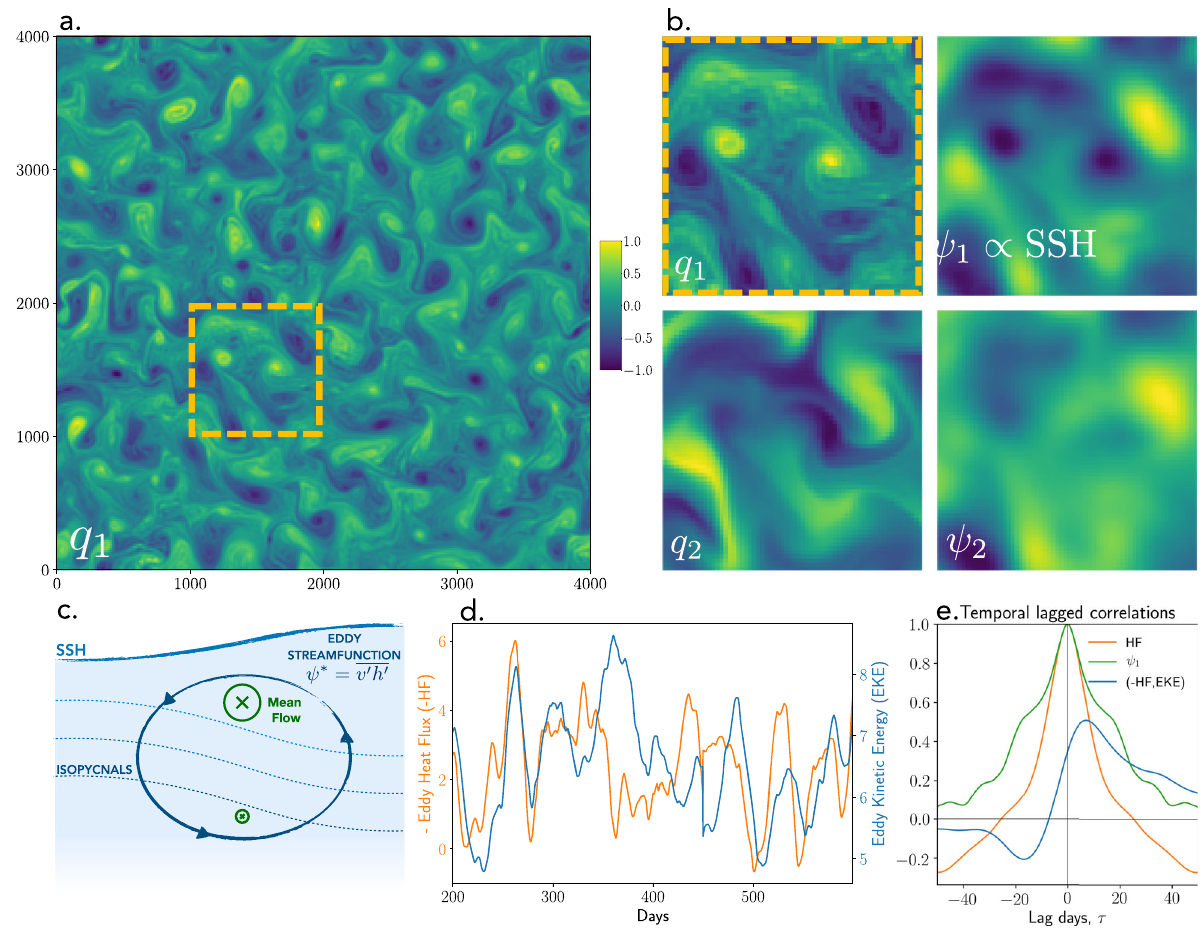
Fig. 1 Simulations of baroclinic geostrophic turbulence on a β -plane. a Snapshot of the upper-layer potential vorticity fi eld, q 1 , showing the prominence of mesoscale eddies; orange dashed square shows a representative 1000 × 1000 km subdomain. b Subdomain snapshots of potential vorticities q i and streamfunctions ψ i in the upper ( i = 1) and lower ( i = 2) model layers. Note, the sea surface height ( SSH ) is proportional to the top layer streamfunction, ψ 1 . All variables have been non-dimensionalised such that their extremal pixel has a value of modulus 1. c Cross-sectional schematic of a strati fi ed ocean, demonstrating the thermocline tilt and corresponding vertically sheared mean fl ow (for the northern hemisphere); the cumulative impact of all eddies creates an overturning eddy streamfunction, ψ *, that acts in a direction to fl atten the thermocline slopes and decelerate the mean fl ow. d Temporal evolution of the subdomain-averaged eddy heat fl ux HF (it ’ s negative is plotted with the orange curve) and the domain-averaged eddy kinetic energy EKE (blue) demonstrating strong fl uctuations within the statistically equilibrated mesoscale turbulence on monthly timescale. e Autocorrelation functions for the eddy heat fl ux (orange), sea surface height snapshots (green), as well as the lagged correlation between the negative eddy heat fl ux and the eddy kinetic energy (blue), with positive lags corresponding to the eddy heat fl ux preceding the eddy kinetic energy. Note that the eddy fl uxes decorrelate almost twice as fast compared to the sea surface height snapshots and the heat fl ux is an early predictor of the eddy kinetic